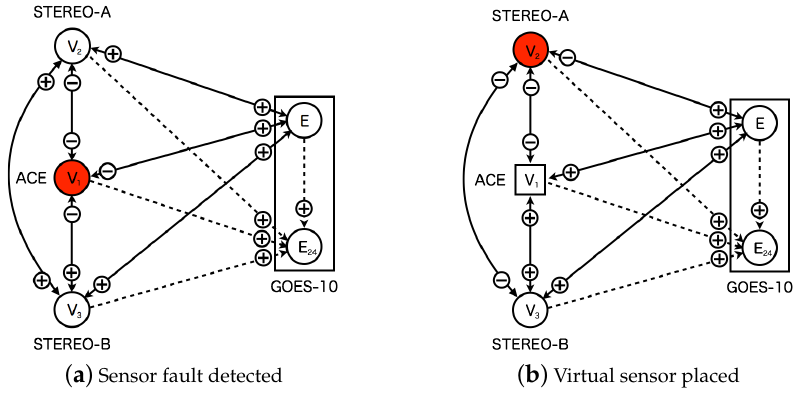
Figure 7. Replacement process of faulted sensors in the dynamic relational network. ( a ) The real sensor ( V 1 ) of ACE is detected as fault; ( b ) The virtual sensor ( V 1 ) of ACE is created. The circles and squares indicate the real sensor nodes and the virtual sensor nodes respectively. The sensor nodes colored white (colored red) are normal (abnormal). The rectangles indicate region of the satellite. The two sensors of GOES-10 is shown in the regions of the rectangles. The solid lines indicate diagnosis flow of mutual diagnosis. The dashed line indicate diagnosis flow from real sensors to virtual sensors for prediction. The plus (minus) indicate diagnosis result normal (abnormal) from source nodes to target nodes.